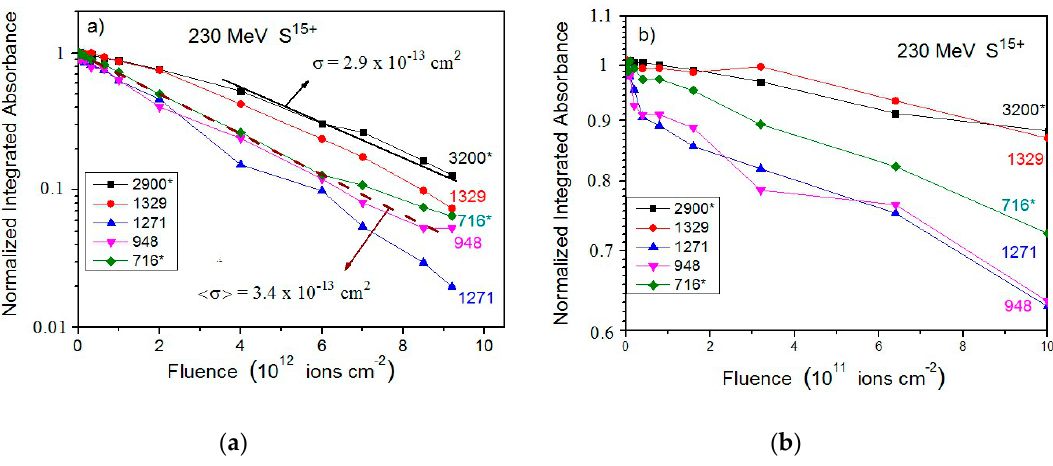
Figure 9. ( a ) Integrated absorbance decrease of five valine bands as a function of 230 MeV S 15+ projectile fluence. Data have been normalized to unity for the virgin sample. The dashed line represents degradation with the average cross section < σ > . ( b ) Zoom of the same data for the low fluence region. (*) means overlapping with product’s band.